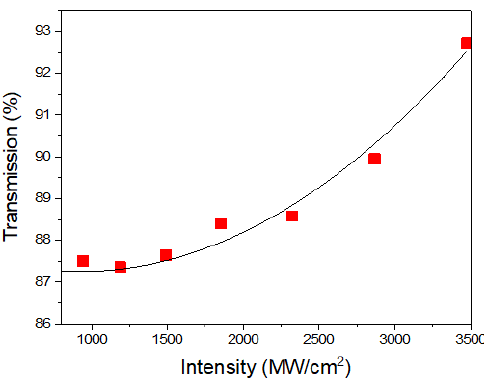
Figure 2. Nonlinear transmission measurement of the DNA SA at a wavelength of 1550 nm.